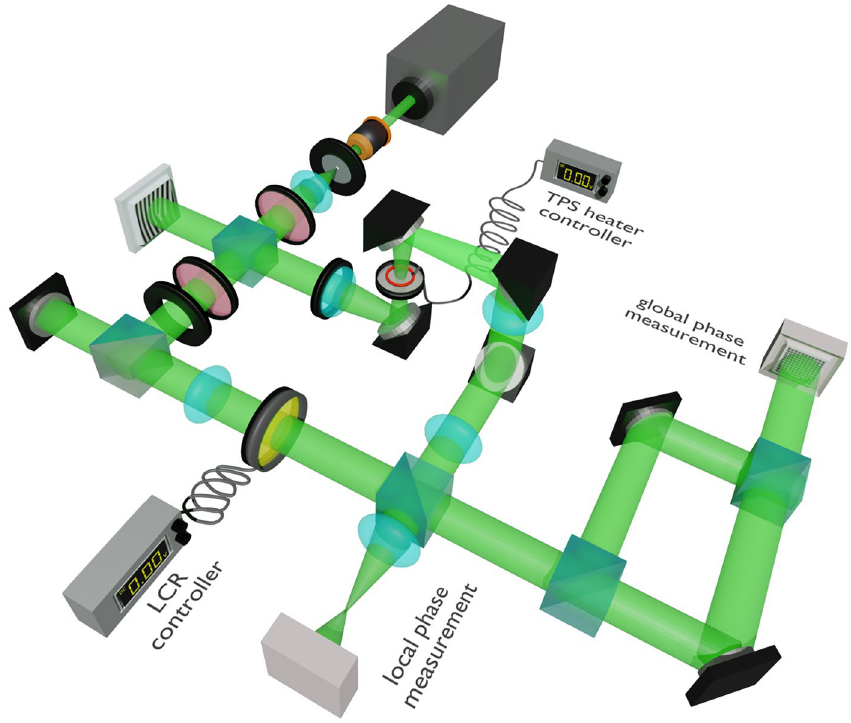
Figure 3. Schematic of experimental setup. The spatially filtered Gaussian beam is divided using a polarization beam splitter. The transmitted beam passes through a lens that generates a spherical wavefront. The second beam reflects off a spatial light modulator (SLM) and then passes through the TPS. Two measurement types are accommodated. The first one, labeled as "global phase measurement", is the self-interference of the scattered beam, which is realized by blocking the reference arm with a mechanical shutter. The second measurement, labeled as "local phase measurement", comprises four separate measurements to infer the spatial distribution of complex scattered field. This is achieved using a liquid crystal retarder (LCR) operated at a rate of hundreds of